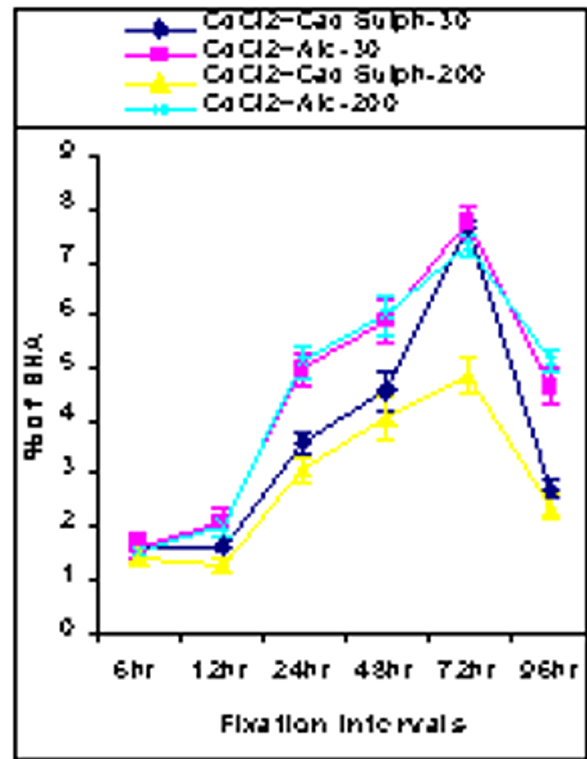
Figure 9 Showing time-dependent frequencies of Cad Sulph-30 post- fed and Cad Sulph-200 post-fed series versus their respective CdCl 2 treated alcohol-30 and alcohol-200 control mice. Chromosome aberration (CA)-5; Mitotic index (MI)-6; Micronucleated erythrocytes (MNE)-7 and Sperm head anomaly